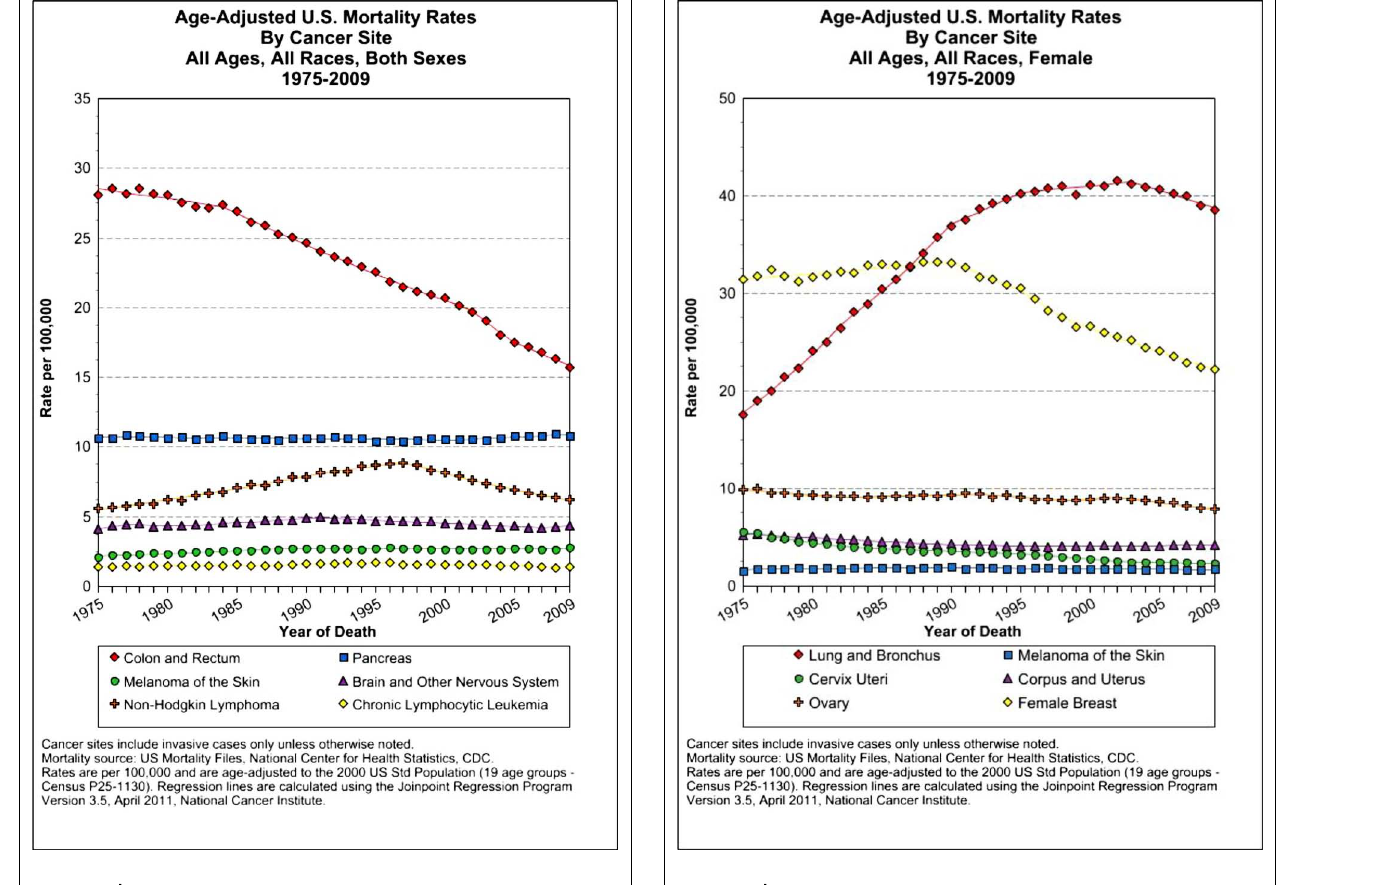
FIGURE 2 |Age-adjusted mortality rates for specific cancer types in males and females, all races combined, US SEER data (Howlader etal., 2011).